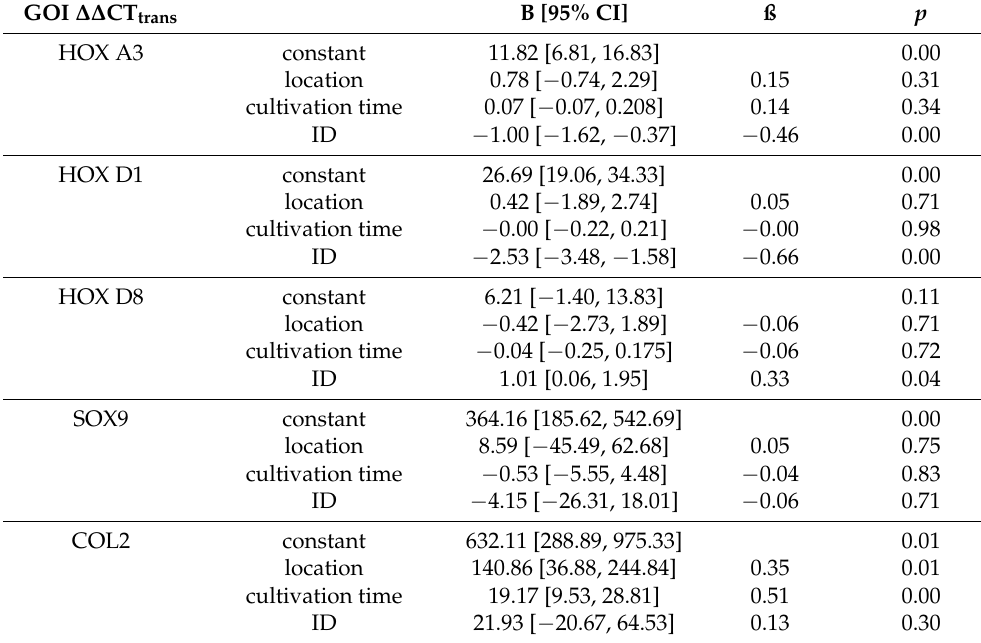
Table 4. MLR coefficients (B) and corrected coefficients ( ß ) of constant, predictors, and covariates are presented as well as their significance levels ( p ) for the transformed ∆∆ CT values of each GOI.